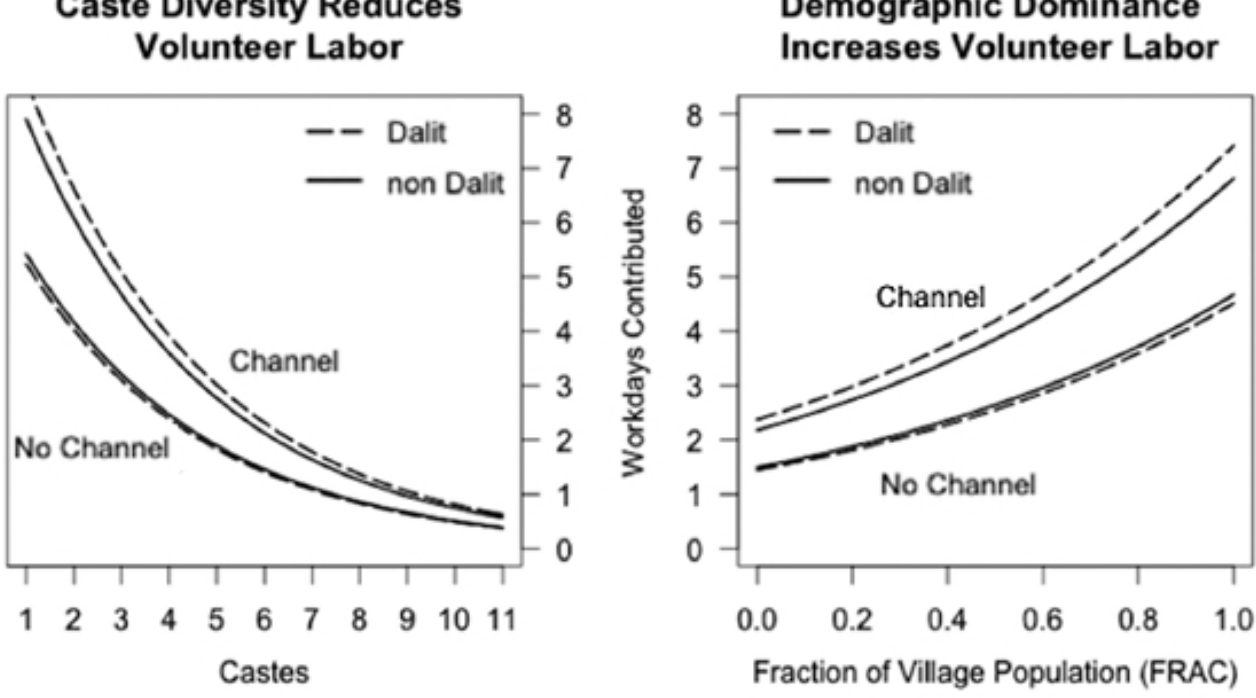
Fig. 1. Influences on volunteer irrigation labor (workdays). LEFT: Negative binomial model predictions of the effect of CASTES show that increasing caste diversity decreases estimated cooperative labor dramatically, whether individuals have CHANNEL access or are Dalit. RIGHT: Estimates of the effects of demographic dominance (FRAC) on workdays shows that increasing ego-centric caste homogenetiy increases willingness to contribute to the upkeep of the irrigation system. The term Dalit refers to the servant groups also termed Harijan, untouchable, or Scheduled